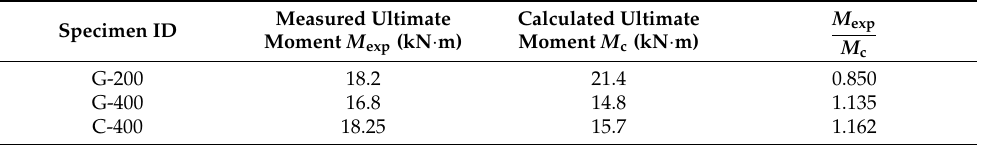
Table 10. Comparison between measured and calculated values of bending capacity of tested beam specimens after high-temperature